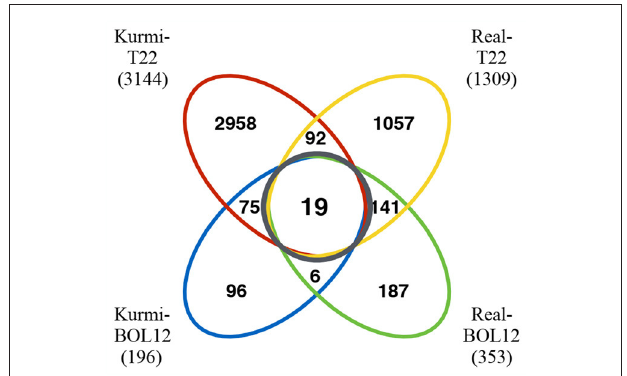
FIGURE 1 | Venn diagram of quinoa genes differentially expressed in response to Trichoderma. Quinoa genes differentially expressed were grouped according to the cultivars and Trichoderma strains studied. The black circle indicates genes differentially expressed in both quinoa cultivars by each of the Trichoderma strains tested. The numbers in parenthesis indicate the number of genes differentially expressed in each of the quinoa- Trichoderma interactions